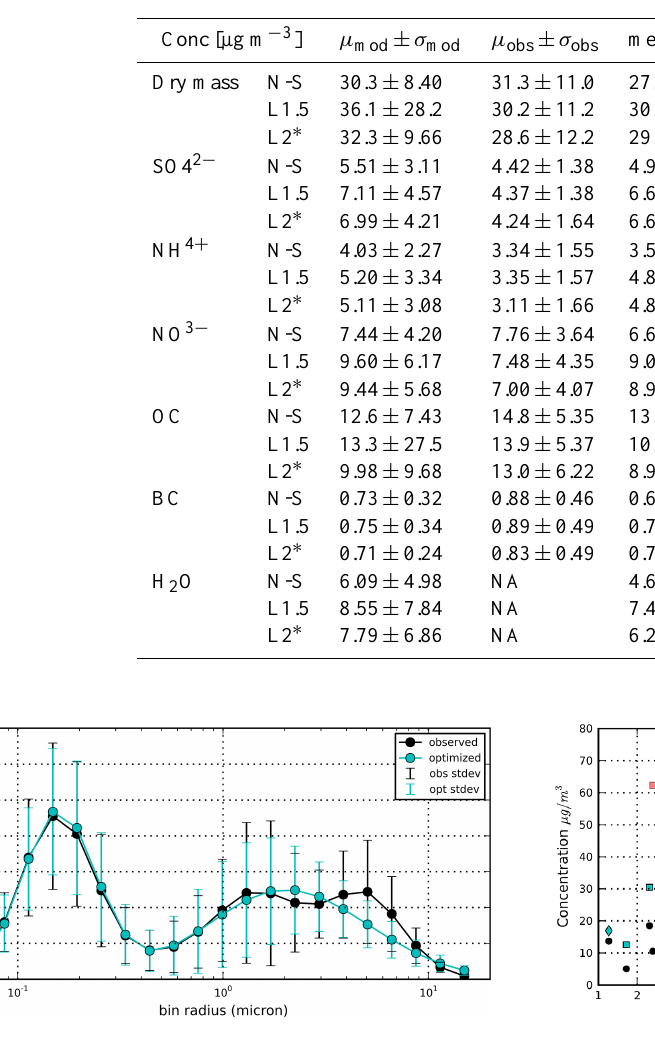
Figure 6. Average AERONET (black dots) and optimized (turquoise dots) volume distribution for the non-suspect data dur- ing 1–14 May. The bars indicate the standard deviation of the data in each bin.